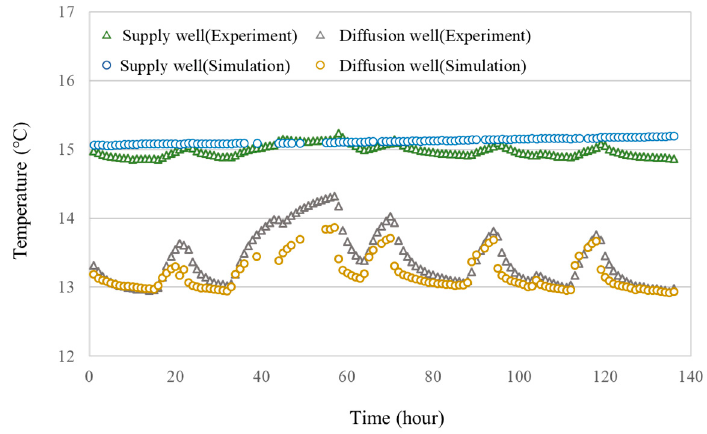
Figure 9. Comparison of the simulation and experiment results.